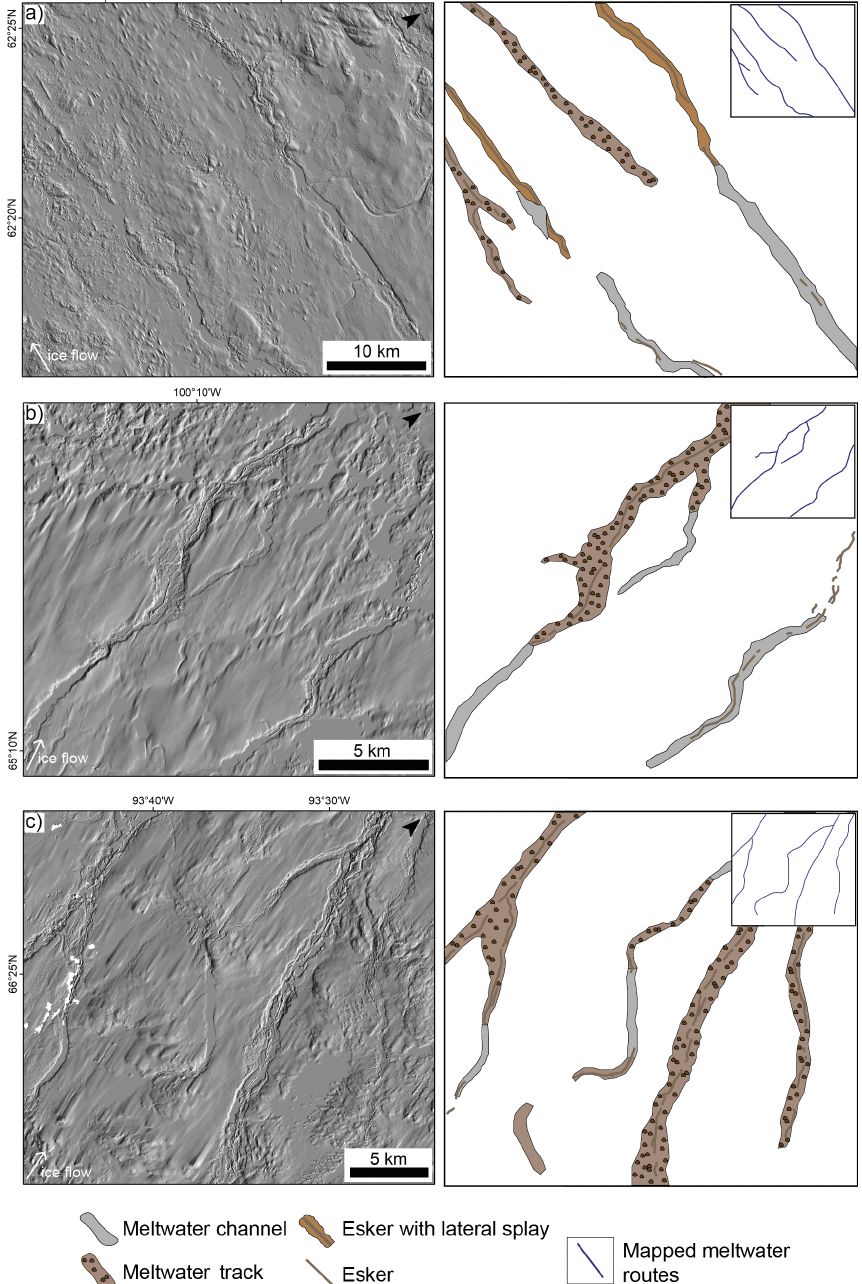
Figure 8. Examples of transitions and associations along meltwater routes. The left panel shows the DEM and the right panel shows an interpretation of the feature types with an inset (top right) showing how meltwater routes are mapped as single lines through all types. White patches in the DEM represent areas of missing data due to the presence of hydrological features (e.g. lakes and rivers) or in areas of cloud cover and shadow. © DEM(s) created by the Polar Geospatial Center from DigitalGlobe, Inc. imagery.